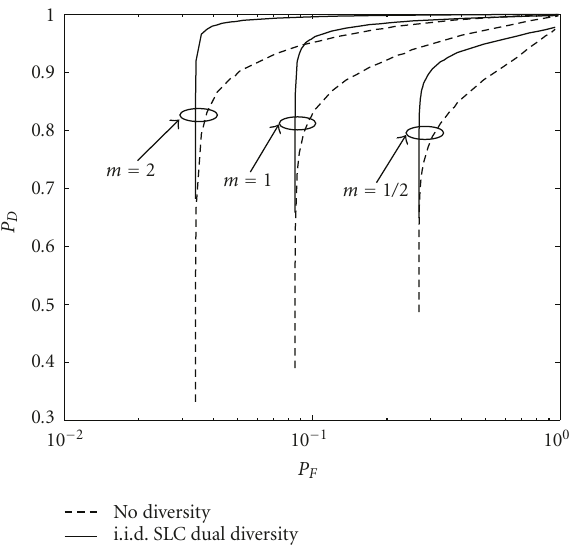
Figure 5: P D versus P F for K = 2 employing Dual SLC (i.i.d. diversity branches) for di ff erent Nakagami fading parameters, γ =